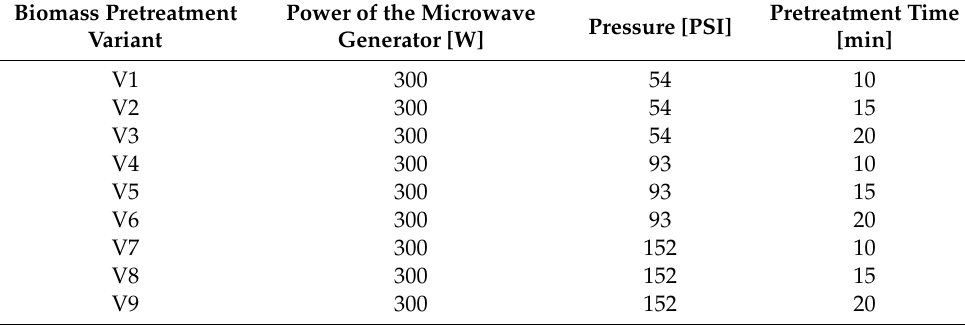
Table 2. Experimental variants used in the selection of optimal conditions of microwave pretreatment. Biomass